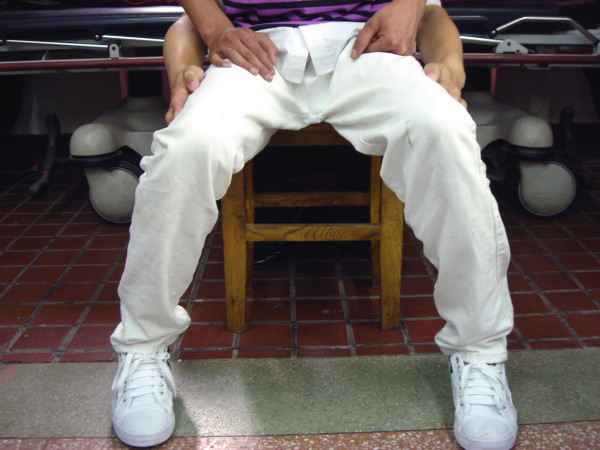
View of Level II patient. The abduction contracture angle is 45° with both hip and knee joint in 90°. This patient came to our hospital for the second surgery due to the incomplete release of the contraction band in the other hospital. The huge scaring in the incision can also been seen.